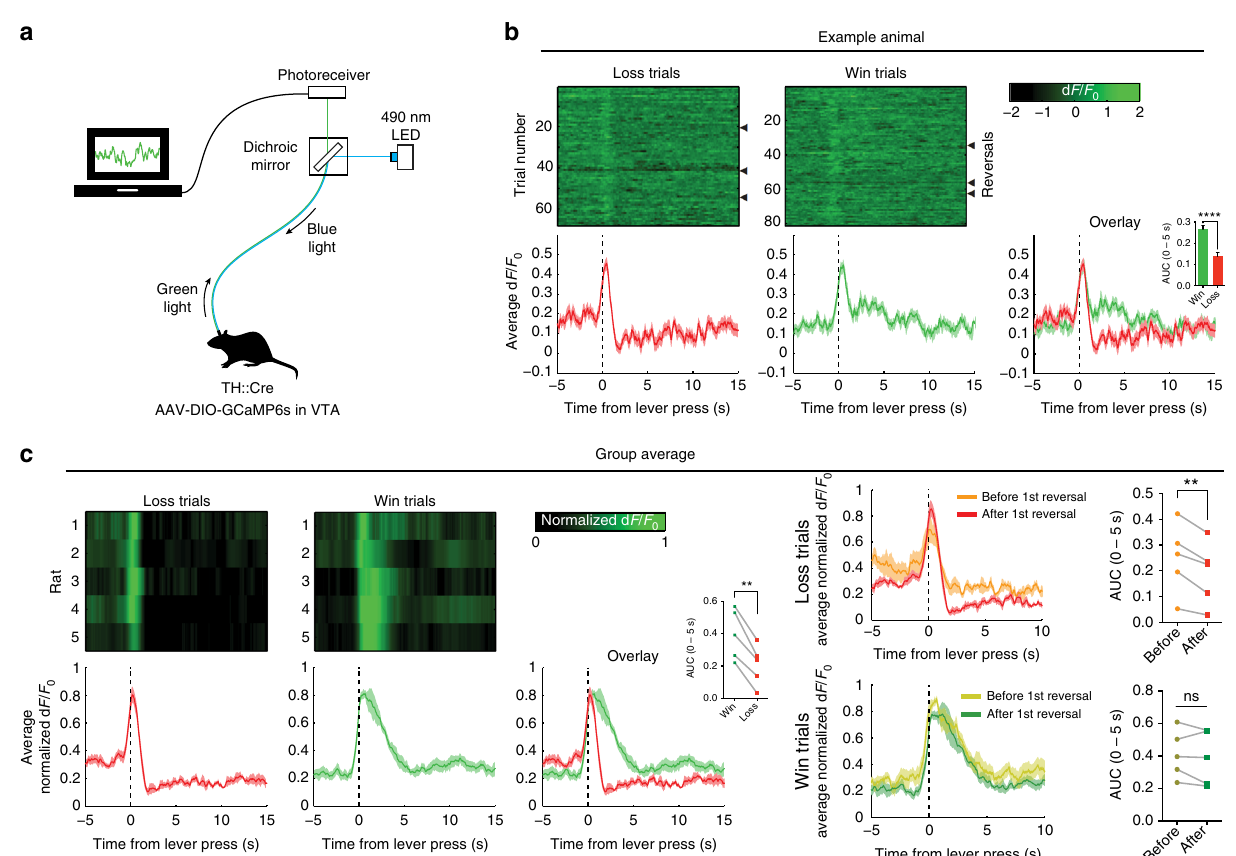
Fig. 3 In vivo fi ber photometry in VTA DA neurons during reversal learning. a Experimental setup. b Reversal learning session of an example animal. Triangles depict a reversal. Data are time locked to a lever press by the rat and (in win trials) immediate reward delivery. Inset shows area under the curve in the fi rst 5 s following lever press (unpaired t -test, p < 0.0001). c Group average. (Left panels) VTA DA neurons responded differentially to wins and losses (AUC (inset), paired t-test, p = 0.0015). (Right panels) Loss trials evoked a stronger negative reward prediction error signal after the fi rst reversal compared to before reversal. (AUC (inset), paired t -test, p = 0.0062 for loss trials, p = 0.3658 for win trials); ns not signi fi cant, ** p < 0.01, **** p <